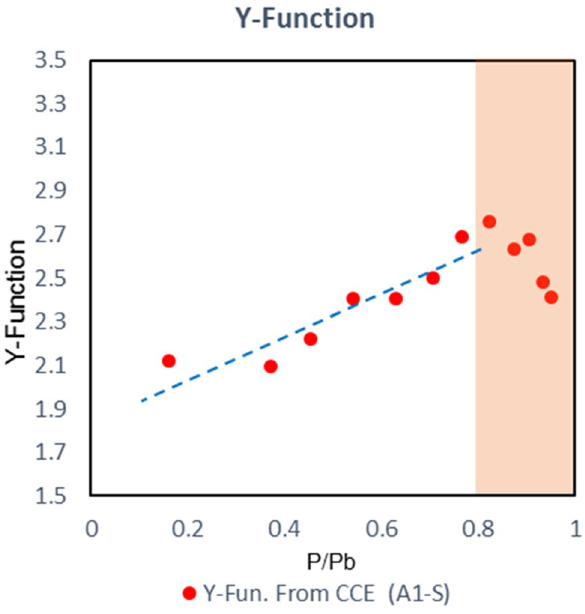
Fig. 22 Invalid Y-function—CCE test